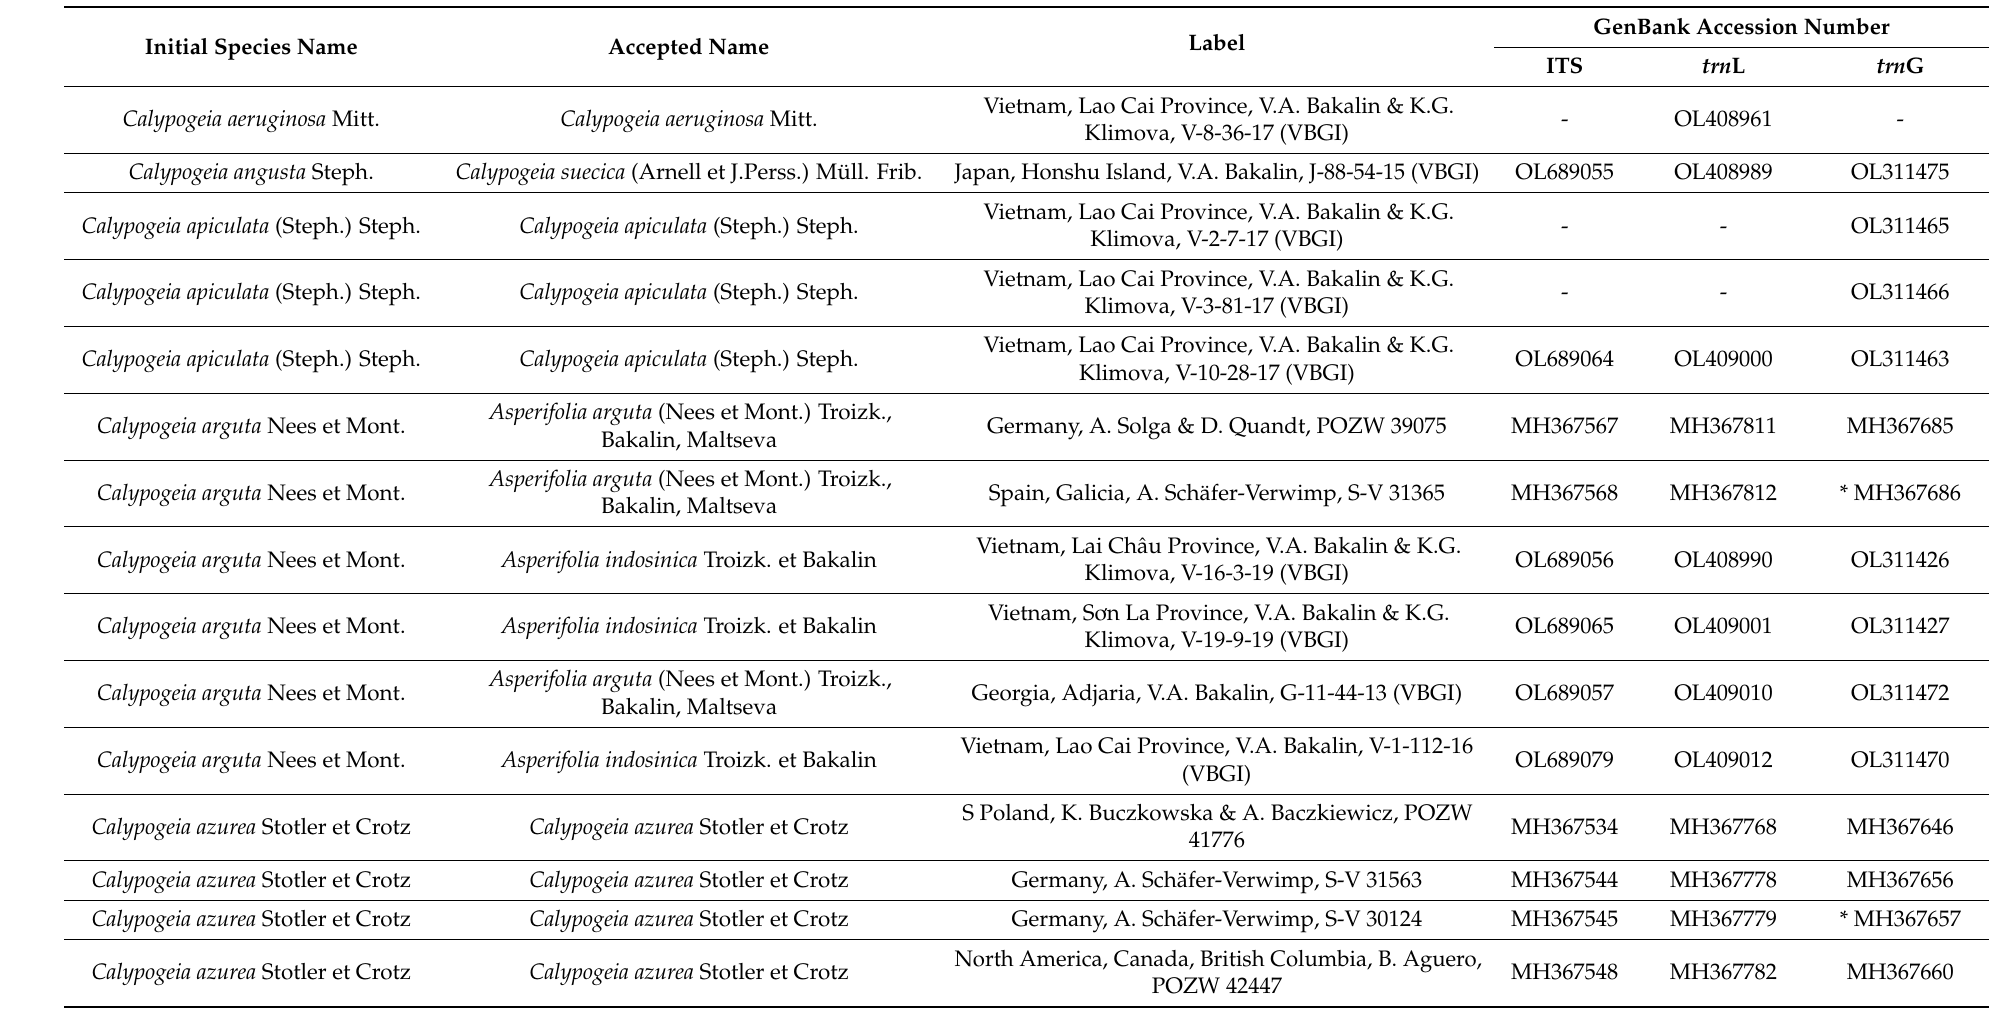
Table 1. The list of taxa, specimen vouchers and GenBank accession